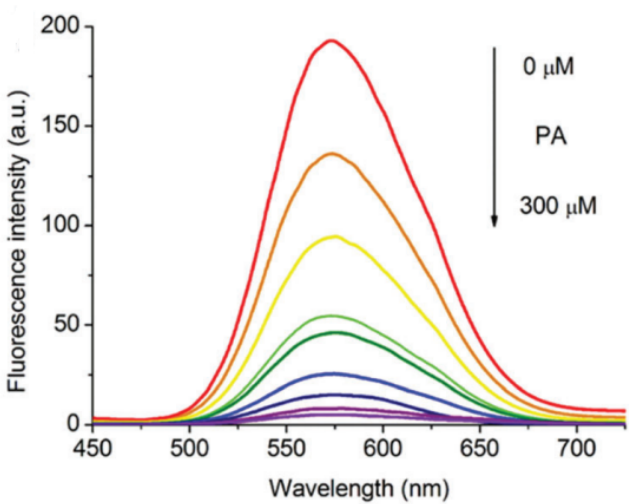
Figure 5. Fluorescence spectra of FP1 in the presence of increasing PA concentration. Reprinted with permission of the Royal Society of Chemistry from [131]. Copyright 2018, permission conveyed through Copyright Clearance Center,